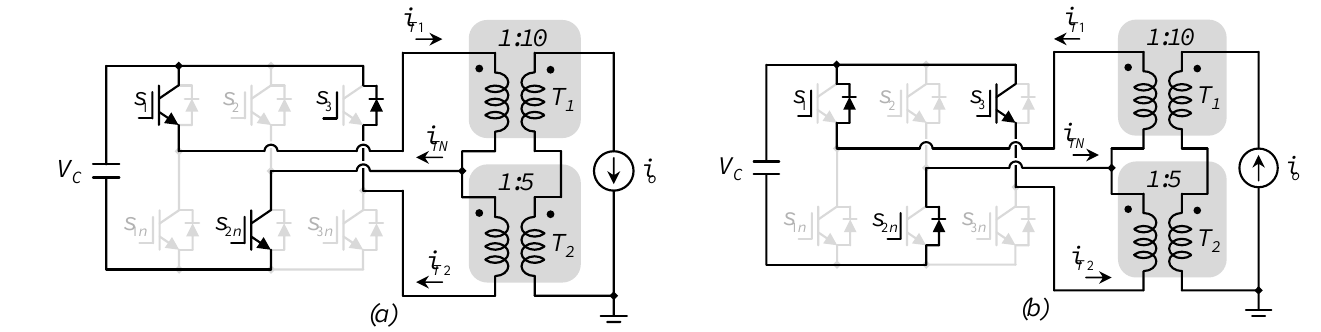
Figure 15. Current flow for different directions of the load current when s 1 = 1, s 2 = 0, and s 3 = 1. ( a ) when the load current is positive and ( b ) when the load current is negative.